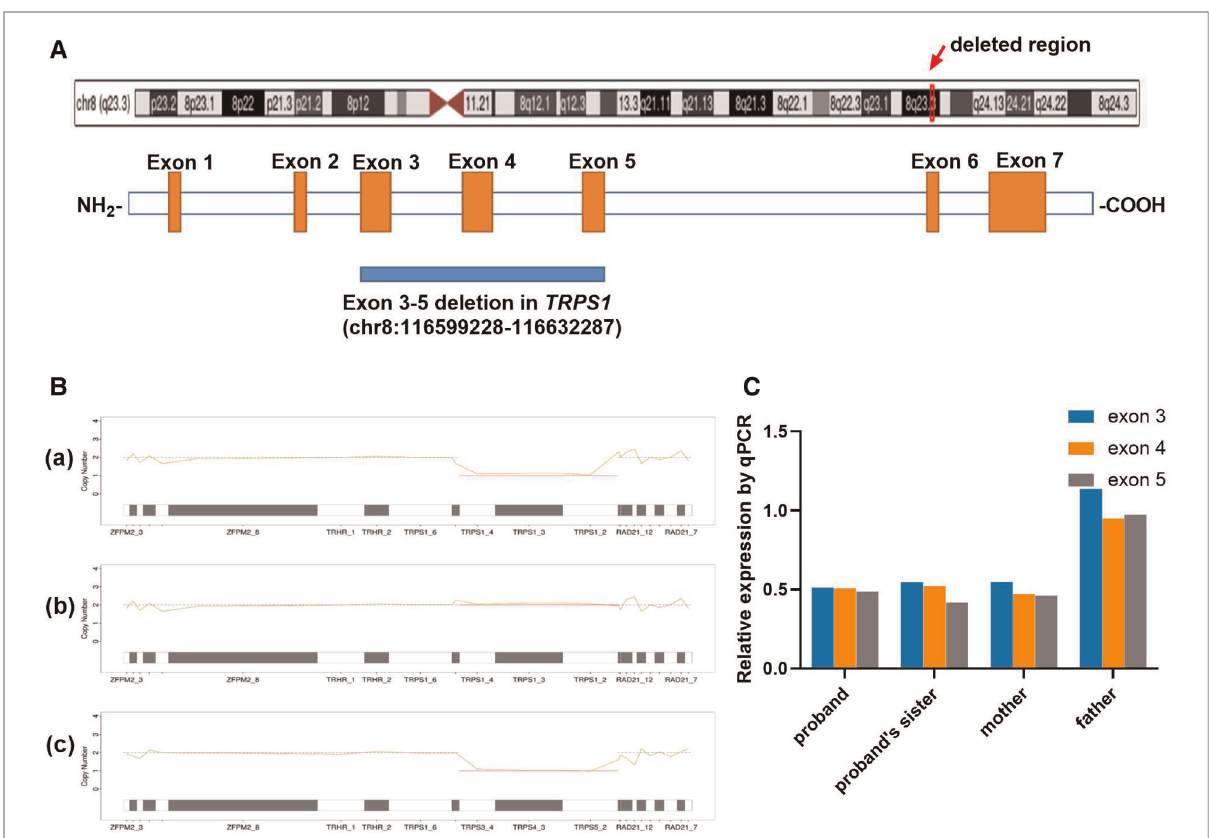
FIGURE 3 Genetic analysis. ( A ) Distribution of the muti-exon deletion in TRPS 1 gene; ( B ) Copy number variation result of proband (a), his father (b) and mother (c) using NGS coverage depth data. The line charts present the copy number of 8q23 region for each family member, including TRPS 1 and the gene ’ s upstream and downstream locations. The proband and his mother were heterozygous for the deletion (×1) for exons 3 – 5 (CDS2-4), and his father was normal at this region. ( C ) qPCR results of all the family members. The proband, his sister and mother were carrying heterozygous deletion of exons 3 – 5 (×0.5), and his father was normal